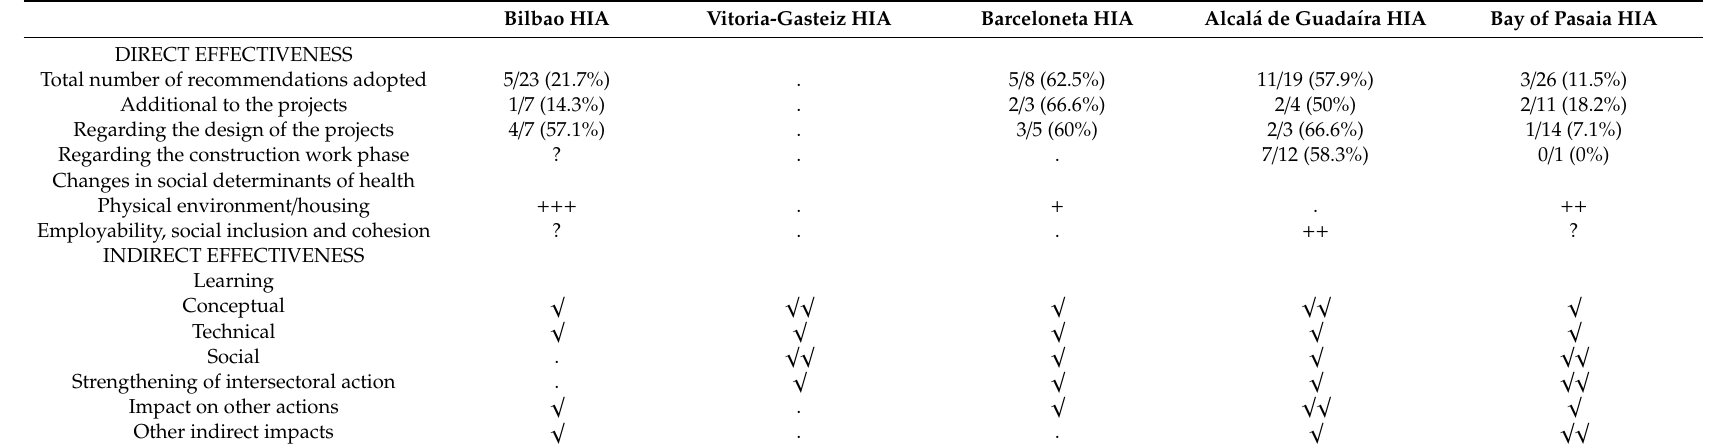
Table 4. Direct and indirect e ff ectiveness of the health impact assessments